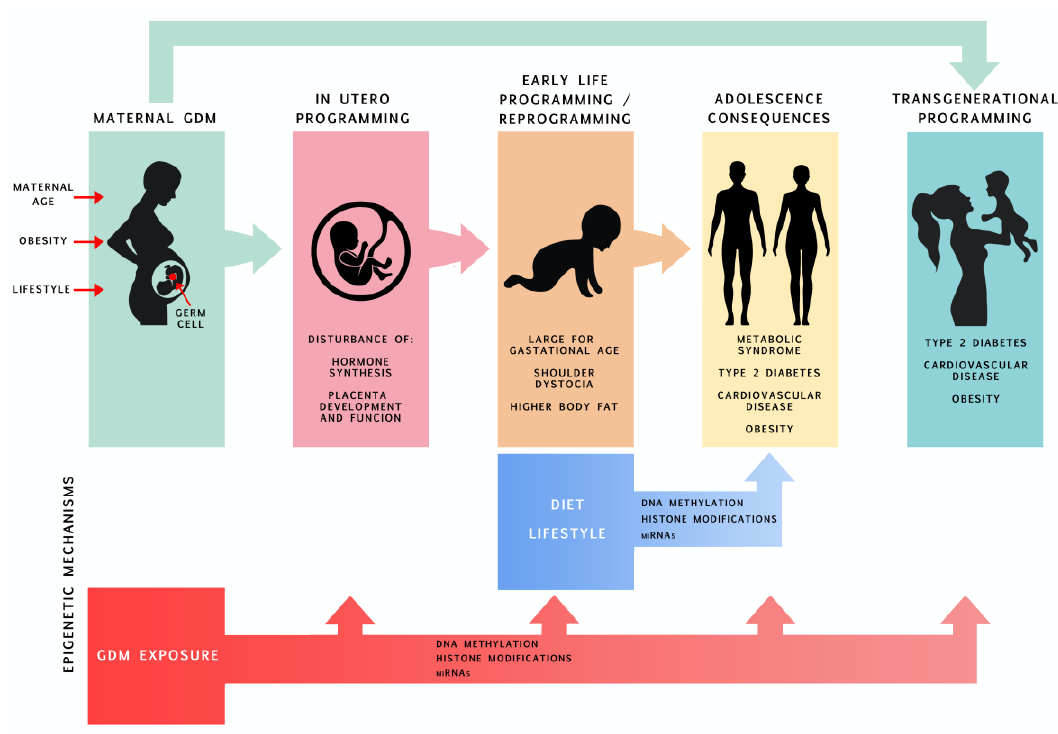
Figure 1. Consequences of o ff spring being exposed to maternal GDM throughout its lifetime with an emphasis on epigenetic programming.